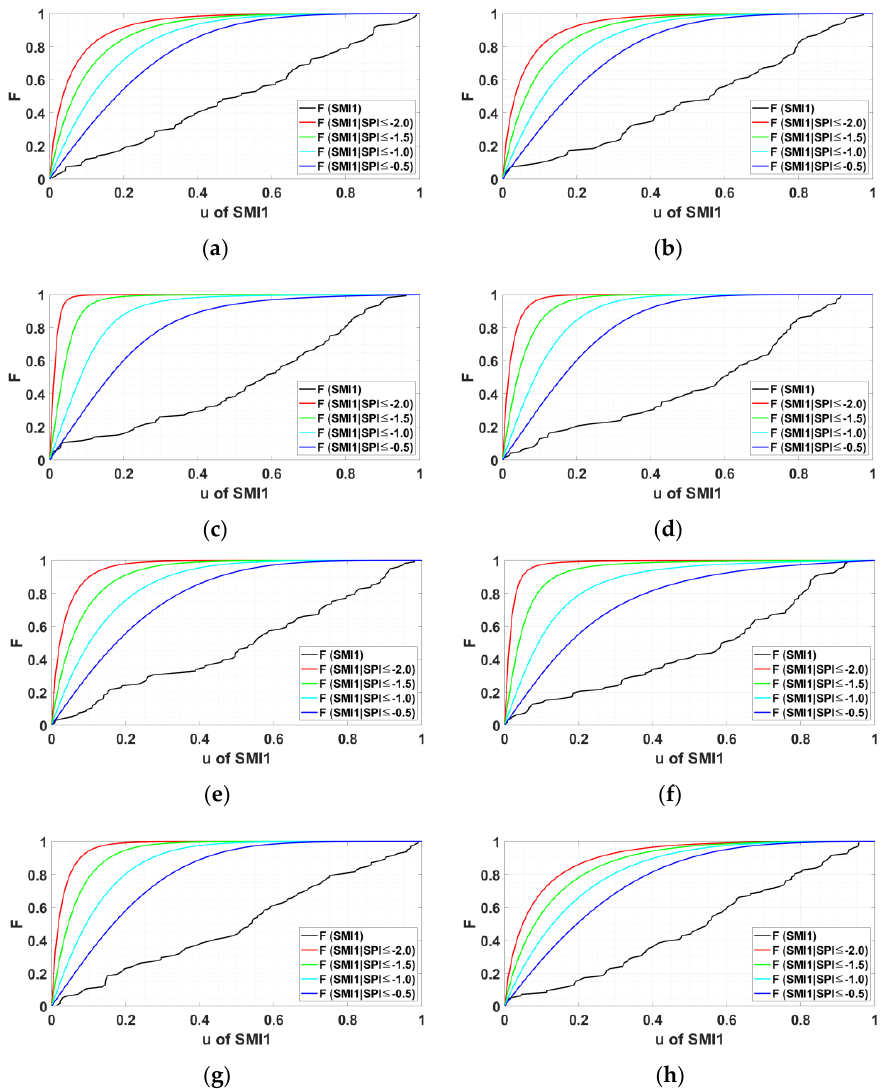
Figure 9. Conditional cumulative probabilities of SMI-1 when different severities of meteorological drought occurred (under extreme meteorological drought conditions (red), under severe meteorological drought conditions (green), under moderate meteorological drought conditions (cyan), and under mild meteorological drought conditions (blue)): ( a ) Andong Dam Basin (Spring); ( b ) Hapcheon Dam Basin (Spring); ( c ) Andong Dam Basin (Summer); ( d ) Hapcheon Dam Basin (Summer); ( e ) Andong Dam Basin (Fall); ( f ) Hapcheon Dam Basin (Fall); ( g ) Andong Dam Basin (Winter); ( h ) Hapcheon Dam Basin (Winter).